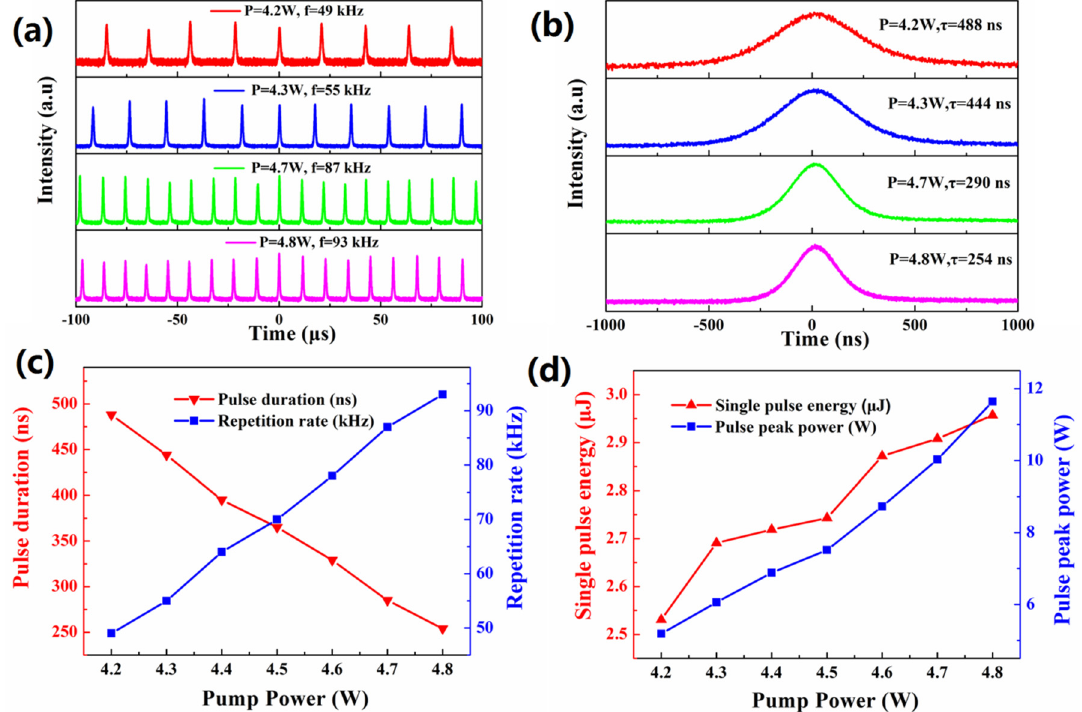
Figure 4. ( a ) Pulse trains and ( b ) Single pulse profiles of the Q-switched Nd:YAG laser; ( c ) Evolution of the repetition rate and pulse duration; ( d ) Single pulse energy and peak power curves with the pump